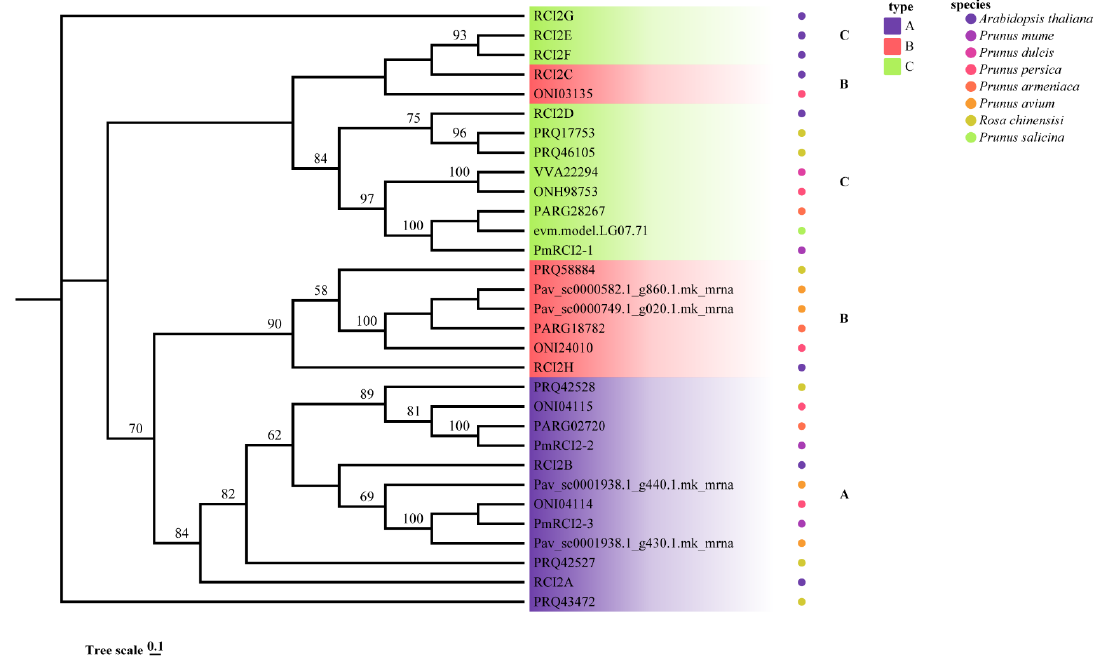
Figure 2. Phylogenetic tree of RCI2s in Rosaceae. The ML phylogenetic tree of RCI2s family in P. dulcis , P. salicina , P. persica , P. armeniaca , R. chinensis , P. mume , and A. thaliana .